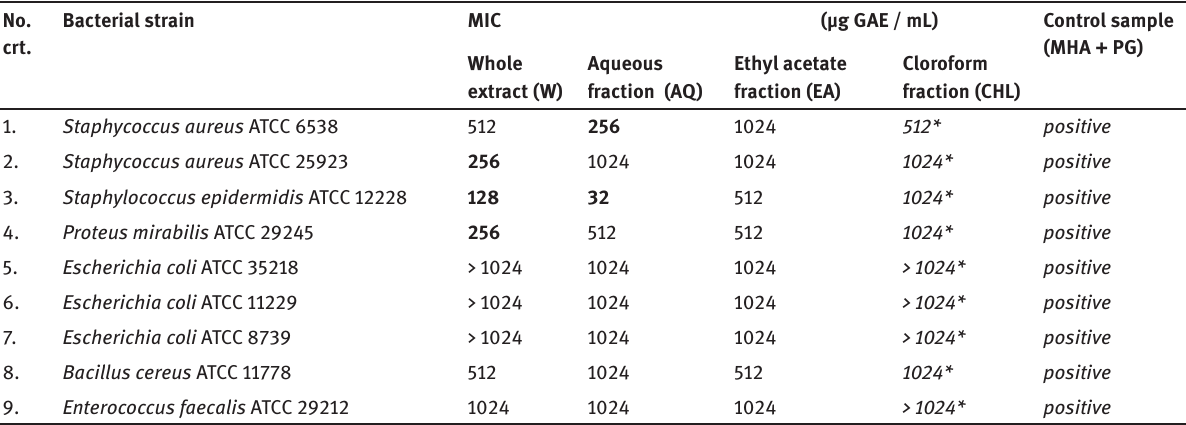
Table 1: MIC values of the four Arctii folium extracts tested on nine ATCC bacterial strains. No. Bacterial crt.